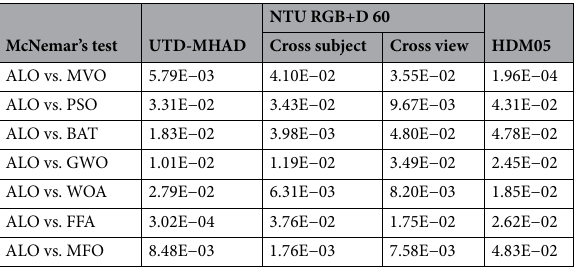
Table 9. Results (based on calculated p -values) obtained by performing the McNemar’s test between the ALO algorithm used in this paper and the other popular metaheuristics used for